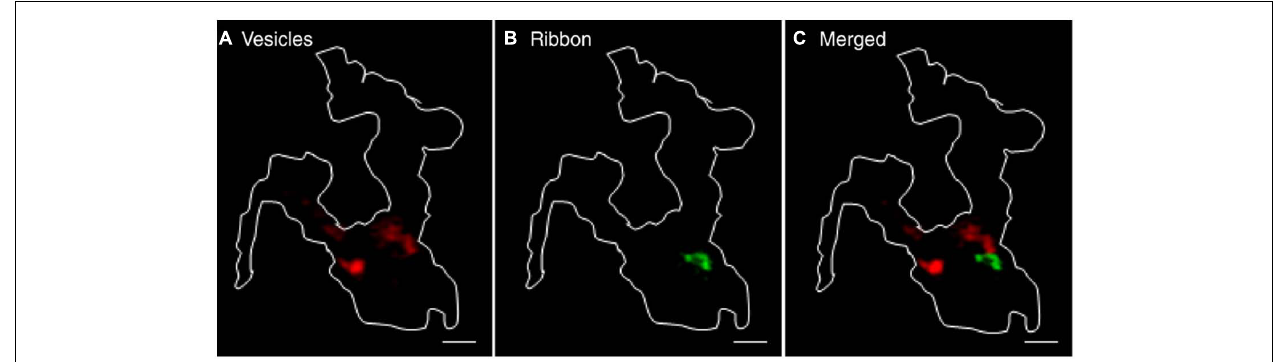
FIGURE 6 | Ca 2 + released from intracellular stores evokes non-ribbon release. A large number of synaptic vesicles in rods were loaded with pHrodo by 30-min incubation. Rods were voltage clamped and loaded with fluo-5F through the pipette. (A) Vesicle recruitment map in a rod terminal that was puffed with 10 μ M ryanodine. The map was generated by subtracting the average of 37 resting images before puff from the average of 52 test images during puff. (B) Ca 2 + entry sites visualized by